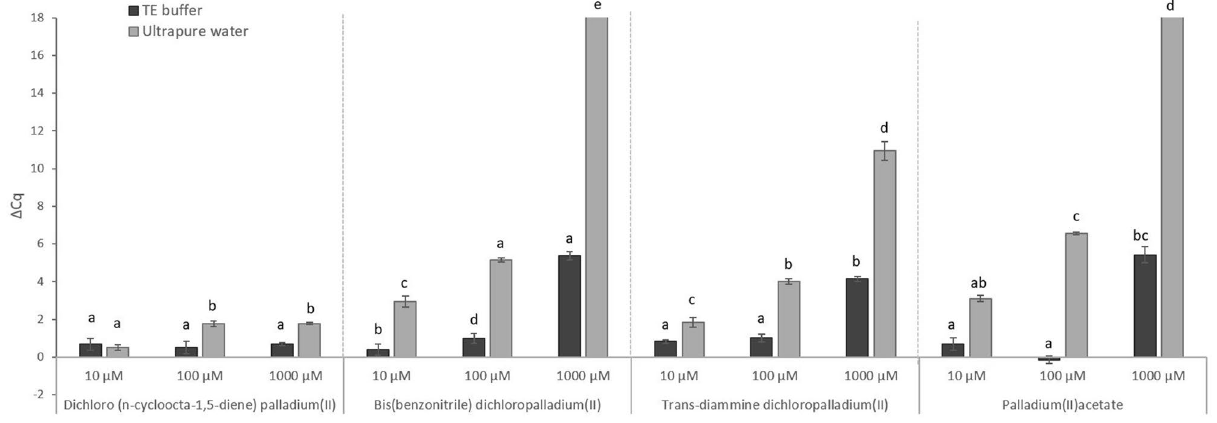
Figure 2. The effect of Pd compound solutions at three concentrations on the amplification of MAP DNA diluted with TE buffer or ultrapure water. The ΔCq values represent the mean difference of Cq values of Pd-treated and mean Cq value of Pd-untreated control samples counted from four biological and technical replicates. Two-way ANOVA with factors of concentration (10, 100, 1000 µM) and dilution medium (TE buffer, ultrapure water) and Tukey´s HSD test were used to evaluate the significance of differences between ΔCq, with all Pd compounds evaluated separately. Identical letters signify statistically insignificant differences (P > 0.05) between ΔCq values, and different letters signify significant differences (P < 0.05). Error bars express standard deviations counted from four replicates. The bars with ΔCq value above 18 indicate that no amplification occurred.